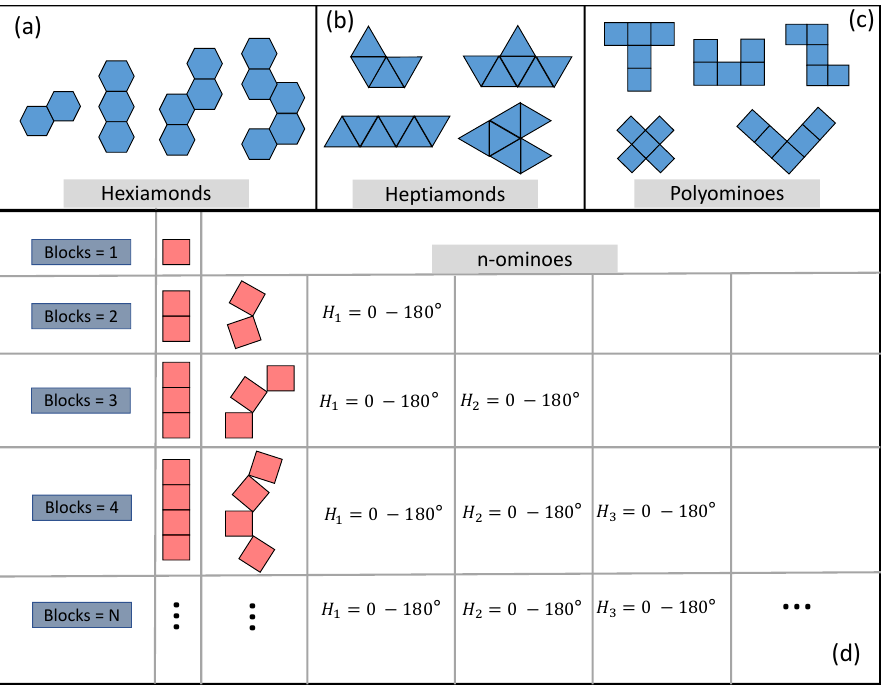
Figure 2. Standard tiling morphologies and their different configurations: ( a ) Hexiamonds, ( b ) Hepti- amonds, ( c ) Polyominoes; ( d ) different configurations of